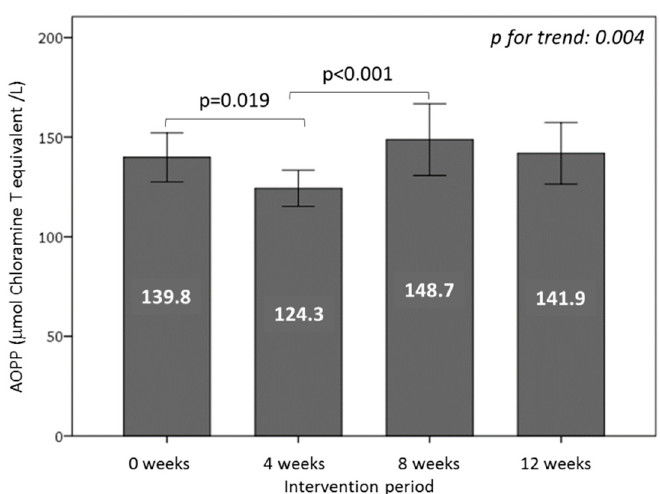
Figure 4. Protein oxidative damage measured as plasma advanced oxidation protein product (AOPP) concentrations of volunteers during the study. Volunteers consumed one WGPF-burger daily between weeks 0 and 4 (intervention period), followed by a washout period (weeks 4 to 8), and then consumed one control-burger daily between weeks 8 and 12 (control period). Bars represent the mean value for each time; lines represent the 95% confidence interval. Analysis of variance (ANOVA) of the four repeated measures with the repeated contrast method was used to evaluate changes between the 4-week intervention periods over time.